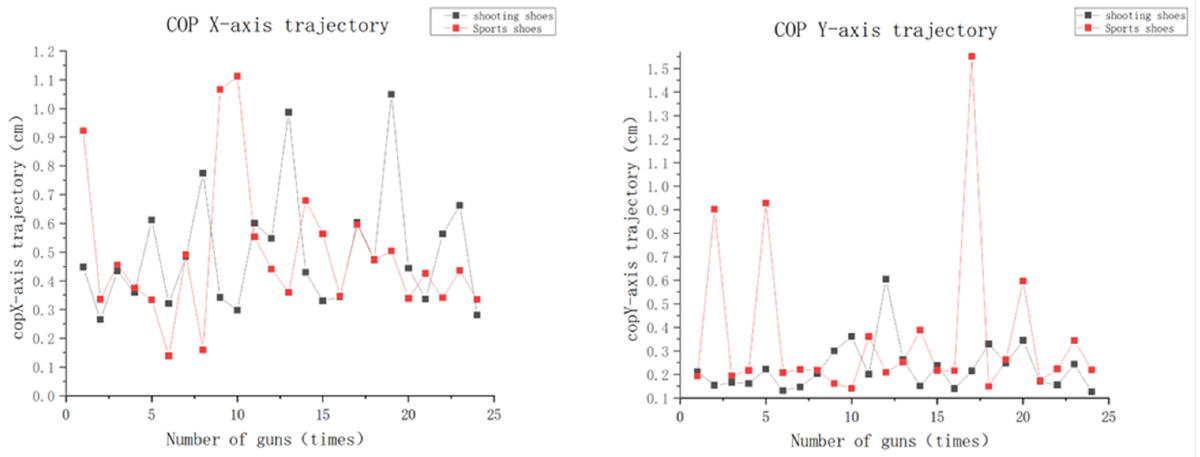
Figure 1. Variation of center of pressure (COP)(x) and center of pressure (COP)(y) travel distance for wearing of shooting shoes and sports shoes.